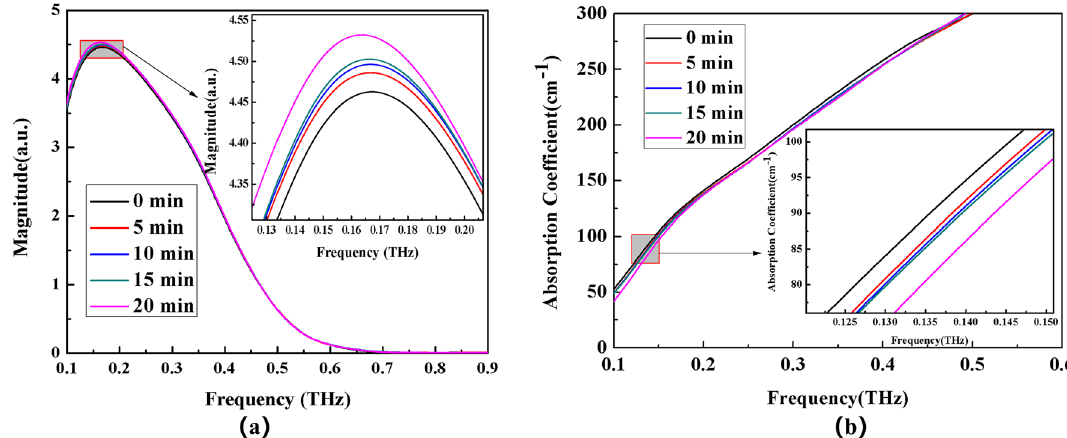
Figure 6. Frequency domain spectrum ( a ) and absorption coefficient spectrum ( b ) of CH 3 COONH 4 solution with different time electric field applied externally.